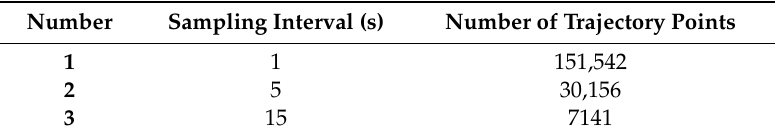
Table 1. Trajectory data information.